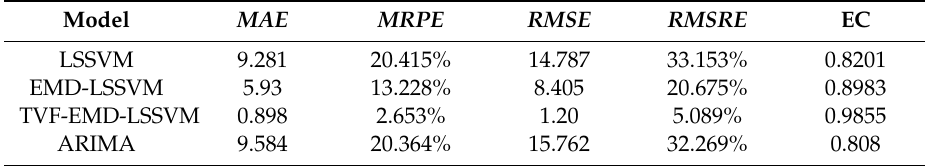
Figure 7. The predictions of different methods (B). Table 4. The comparison results of different methods (B).